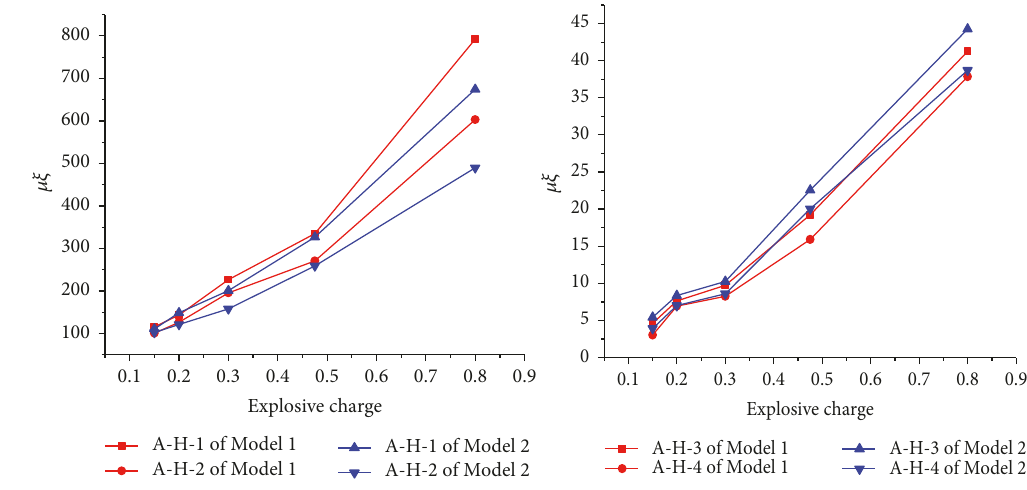
Figure 15: Hoop strain of two models. Table 9: The contact pressure peak between two adjacent layers (MP a